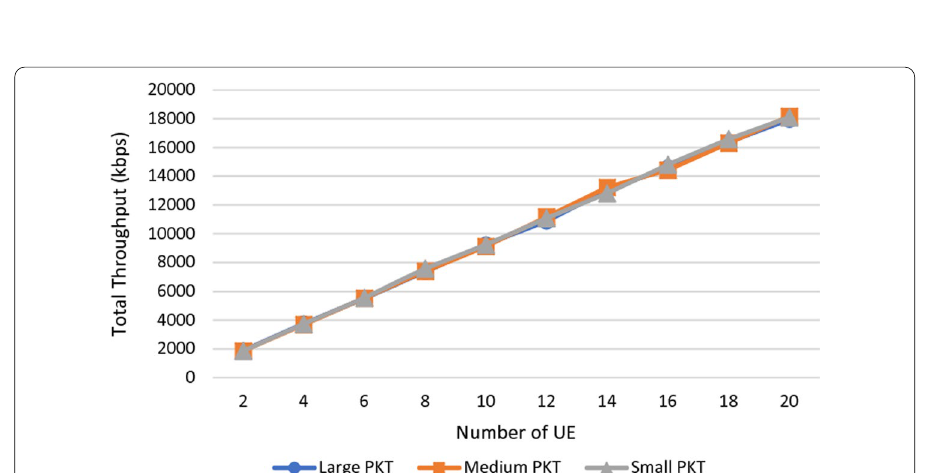
Fig. 19 Analysis of total throughput in different packet size situations; The performance analysis of total throughput in different packet sizes for our proposed EURA